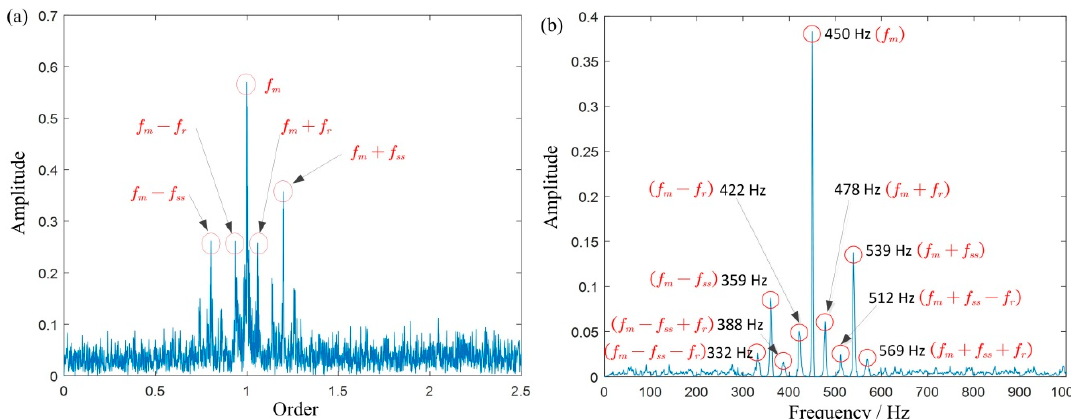
Figure 9. The result analysis of a multicomponent simulated signal: ( a ) order spectrum and ( b ) 2D energy-frequency map.